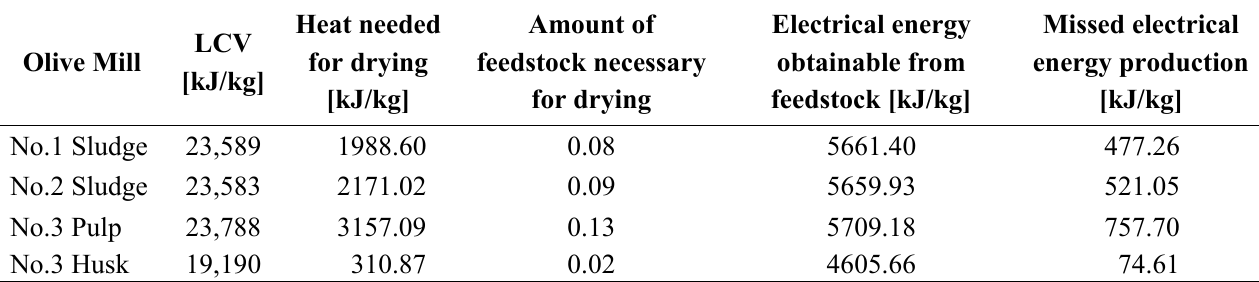
Table 9. Missed electrical energy